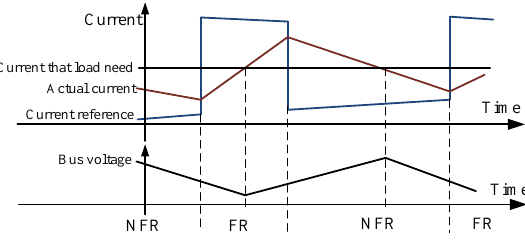
Figure 8. The repeated shocks of the three-branch currents.